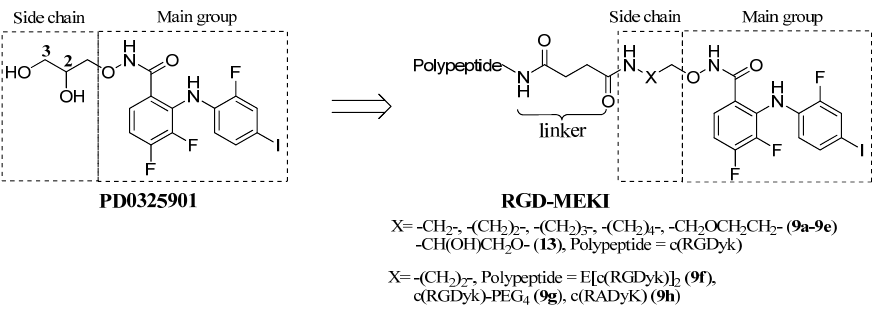
Figure 1. The structures of two series of RGD-PD0325901